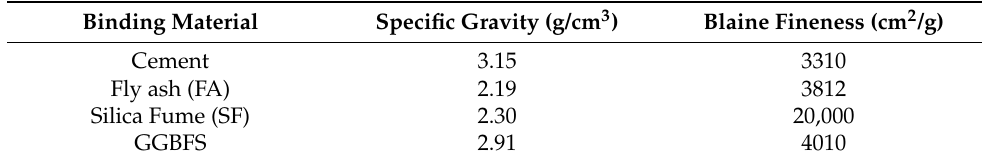
Table 3. Properties of the binding materials used in the concrete